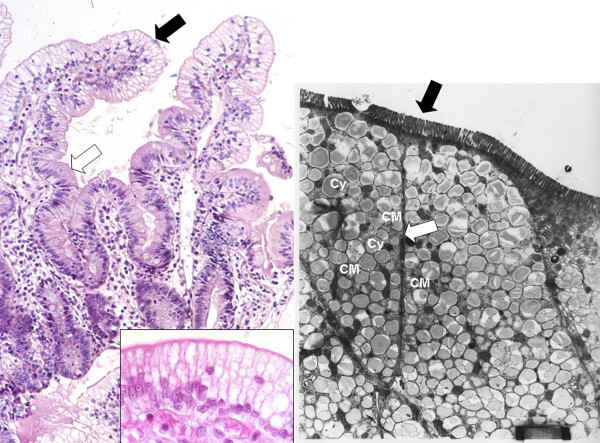
Histology of a jejunal biopsy from a CRD patient. Panel A: photomicrograph of hematoxylin-eosin staining showing vacuolization of enterocytes and well preserved villous structure. The distribution of vacuolization, which corresponds to lipid droplets, is heterogeneous: fat filled enterocytes (black arrow) in the upper part of the villus are associated with normal enterocytes in the crypts (white arrow) (×20). Panel B: Higher magnification (×100) of the same patient's biopsy. Panel C: Electronic microscopy. The pictures show the apical pole of the enterocytes exhibiting well-preserved microvilli (black arrow), numerous chylomicrons (CM) and fat droplets of homogenous size gorging the cytoplasm (Cy). The intercellular membranes demonstrate a complete juxtaposition of intercellular membranes where lipid particles are absent (white arrow) (×4000).